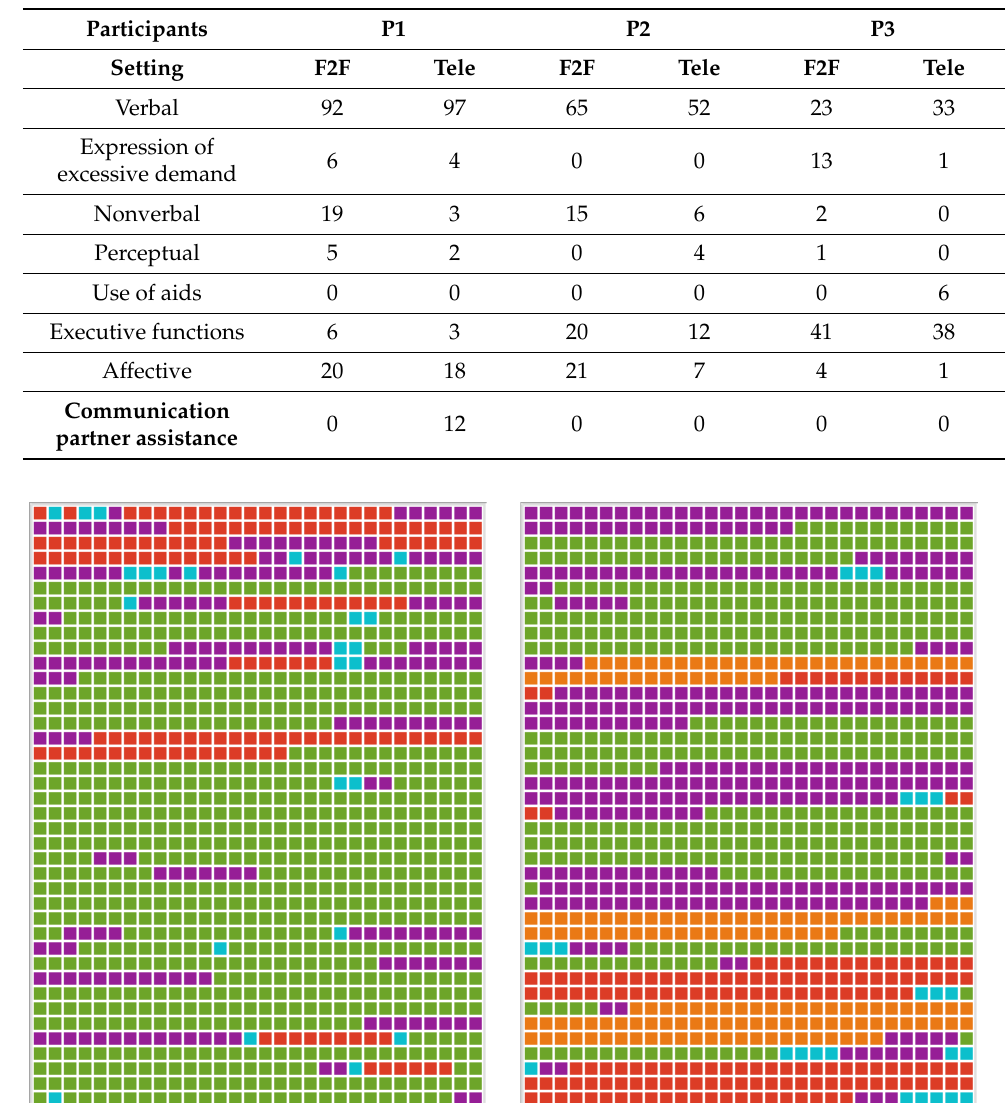
Figure 4. Document portraits of P2–F2F diagnostics ( left ) and telediagnostics ( right ) showing the sequence of codings for the selected document weighted by the length of the segments. Colours of the code system are purple (verbal), pink (expression of excessive demand), red (nonverbal), orange (perceptual), yellow (use of aids), green (executive functions), light blue (affective), and deep blue (aids of relatives).